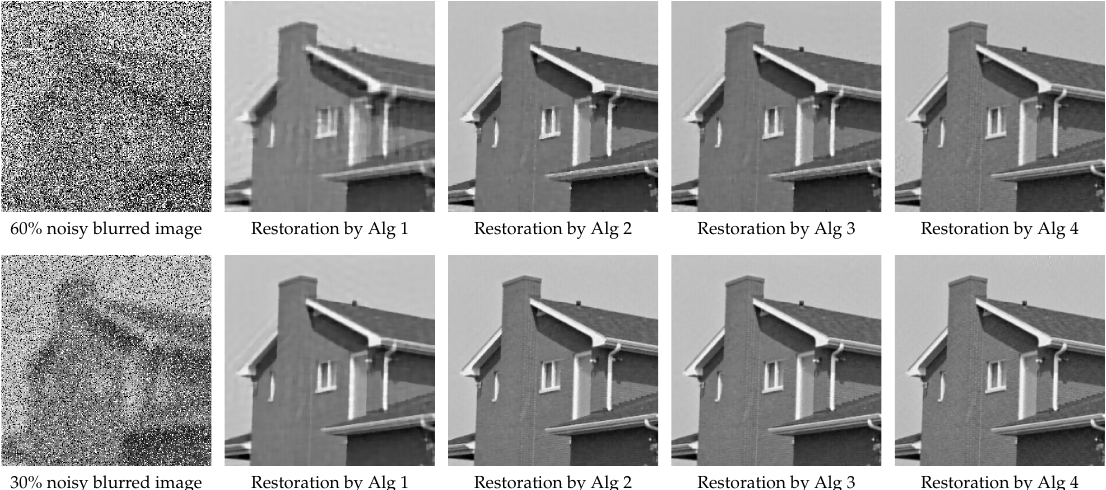
Figure 4. Image restoration for blurred House image with 60% or 30% salt-and-pepper noise.